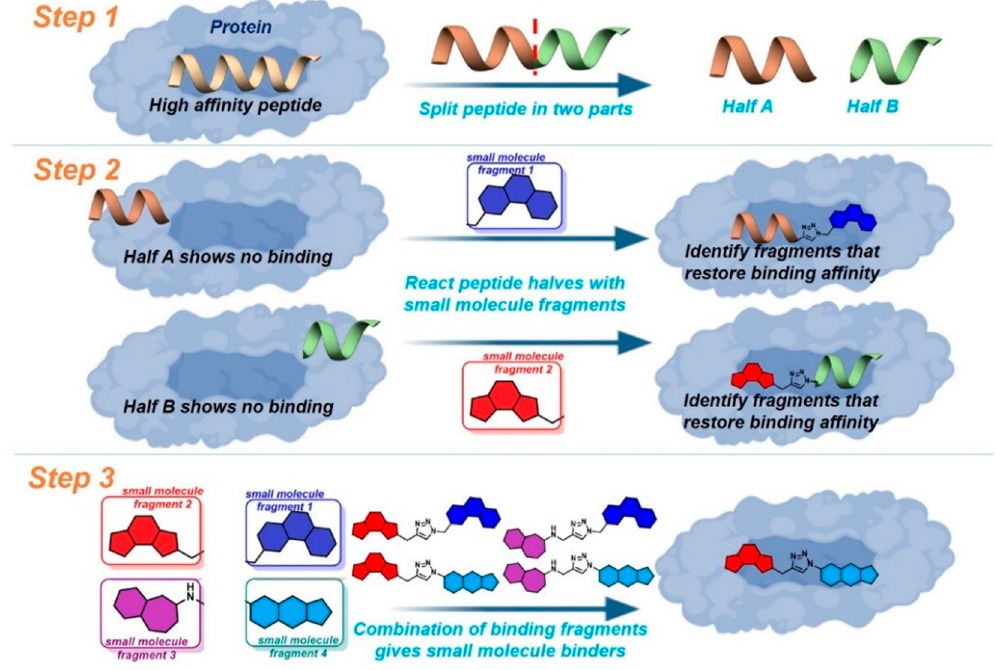
Figure 2. Schematic of peptide-directed binding.